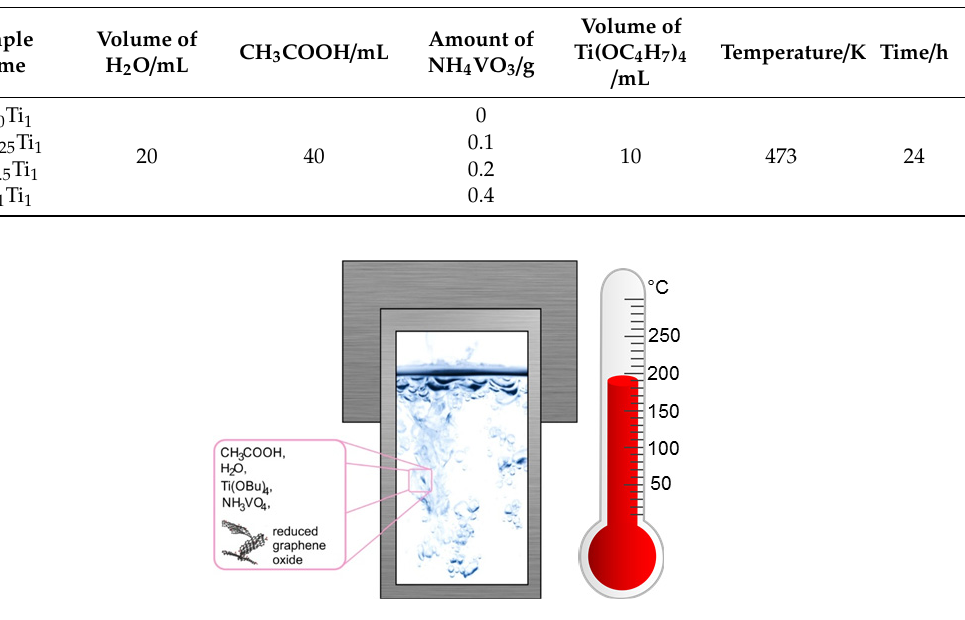
Figure 1. Schematic view of the solvothermal synthesis procedure.